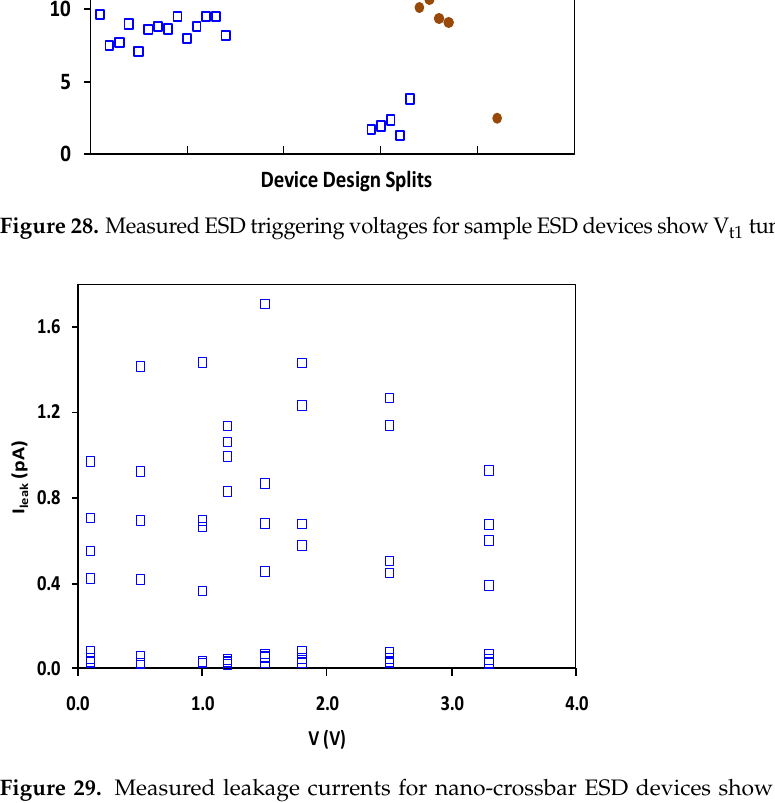
Figure 29. Measured leakage currents for nano-crossbar ESD devices show extremely low ESD-induced I leak [49].